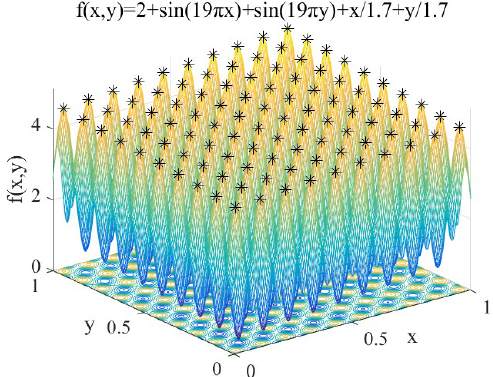
Figure 7. When IAFSA executes AFSA to 120 times.